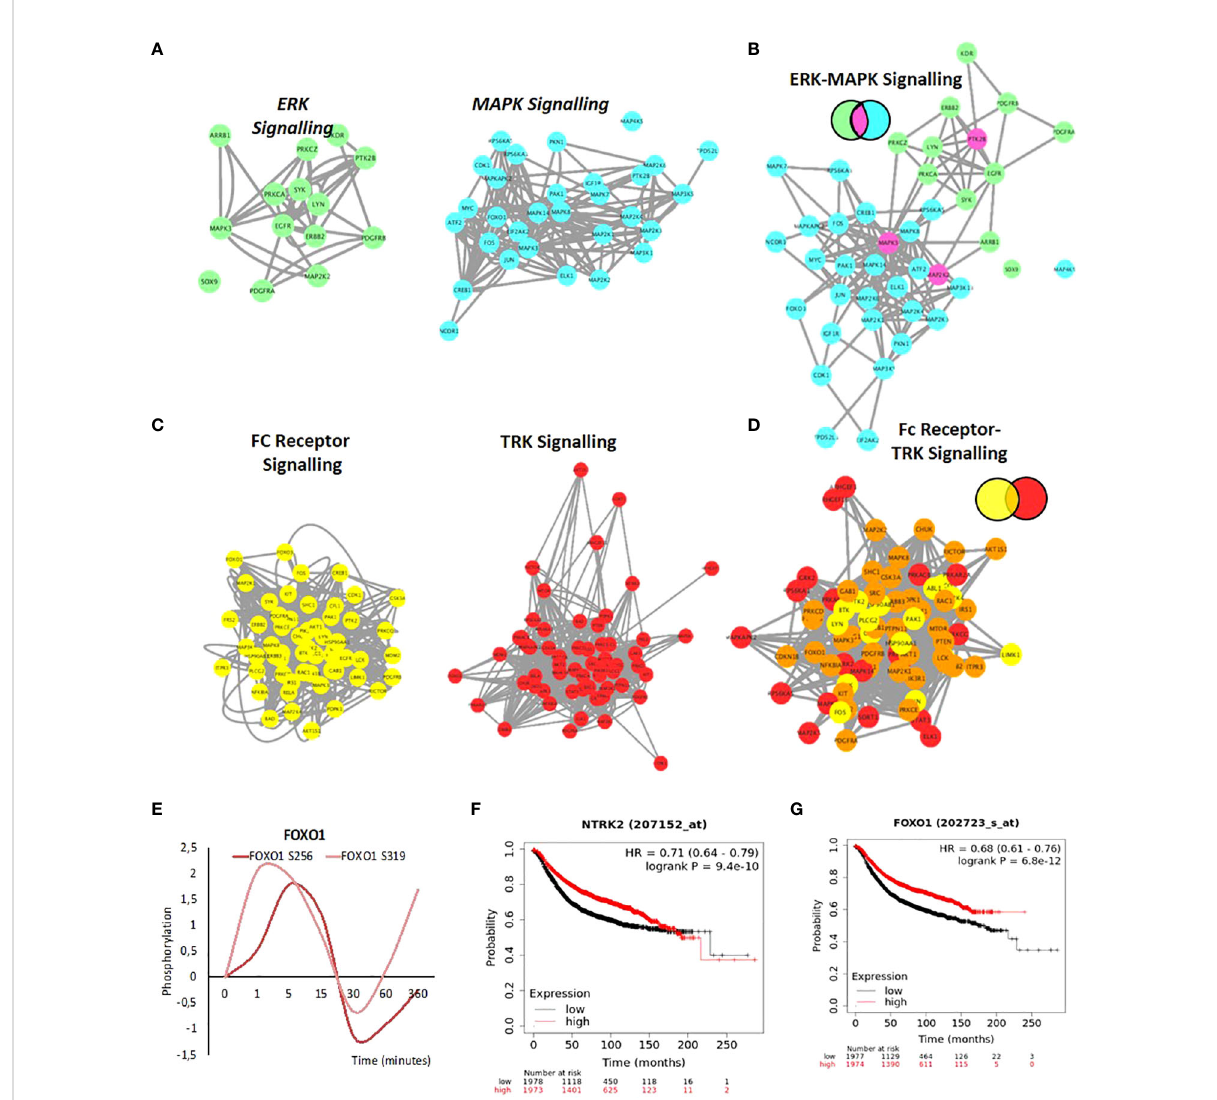
FIGURE 6 Network Integration of signalling networks identi fi ed in response to hormone. (A) PPI network showing the phosphorylated proteins present within the ERK signalling cascade (green) and the MAPK cascade (blue) identi fi ed in response to hormone. (B) Merge of ERK-MAPK networks (A) . The two networks are merged based on known PPI. Proteins annotated in both pathways are colored based on the Venn diagram (fuchsia). (C) PPI network showing the phosphorylated proteins present within the FC-receptor (yellow) and TRK-neurotrophin (red) signalling pathways (yellow) identi fi ed in response to hormone (left and middle panel). (D) Merge of FC-receptor and TRK neurotrophin networks. The two networks are merged based on known PPI. Proteins annotated in both pathways are colored based on the Venn diagram (orange). (E) Rapid and coordinated phosphorylation of FOXO1 S256 and FOXO S319 in response to hormone. Kaplan Meyer overall survival of patients strati fi ed based on the expression of NTRK2 (F) and FOXO1 (G) in breast cancer patients (p=9.4E-10 and 6.8e-12 respectively). All networks, PPIs and integrated cascades are supplied in Cytoscape session